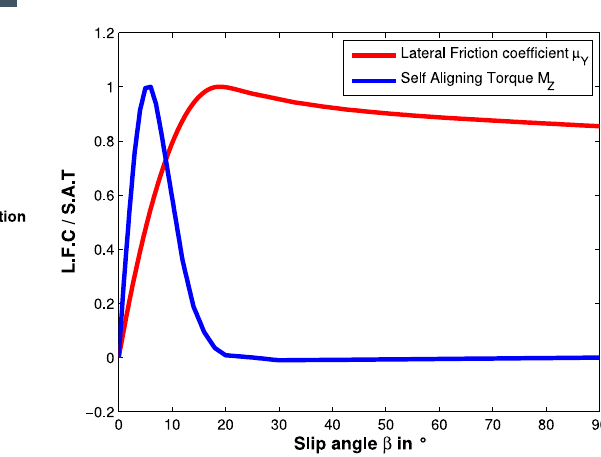
Figure 2. µ Y and M z in the case of an aircraft tire. β denotes the slip angle. The specific values have been